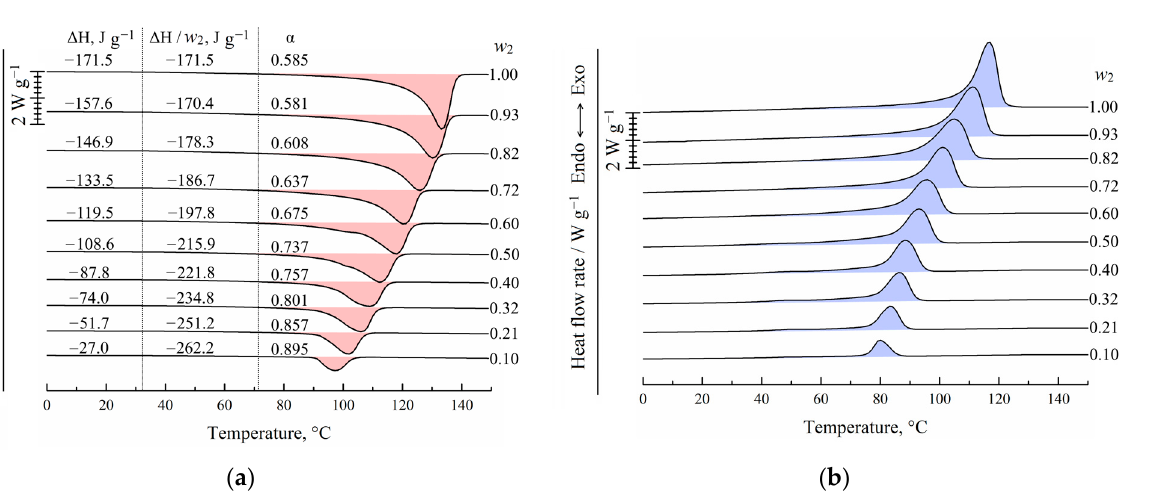
Figure 3. DSC-thermograms for the UHMWPE and its mixtures with o-xylene obtained during ( a ) second heating and ( b ) first cooling. The mass fraction of the polymer ( w 2 ) is shown to the right of the curves. In ( a ), peak area ( ∆ H), melting enthalpy of UHMWPE ( ∆ H/ w 2 ), and corresponding crystallinity degree ( α ) values are shown for each curve.